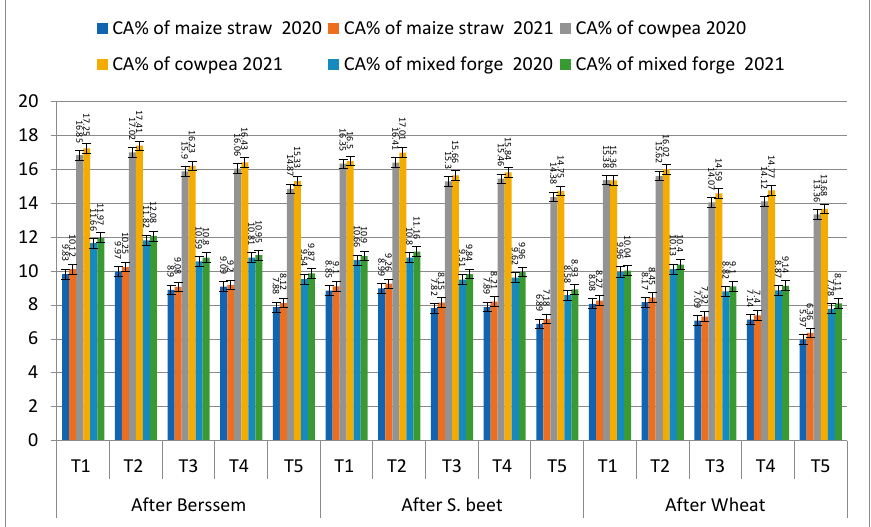
Figure 6. The effect of preceding crops and NPK as well as biofertilizers on the crude ash percentage of maize straw intercropping with forage cowpea and mixed during 2020 and 2021 seasons. T1: 100% mineral NPK, T2: 75% mineral NPK + Arbuscular Mycorrhiza fungi, T3: 50% mineral NPK + Arbuscular Mycorrhiza fungi, T4: 75% mineral NPK + Mycrobein, T5: 50% mineral NPK + Mycrobein.